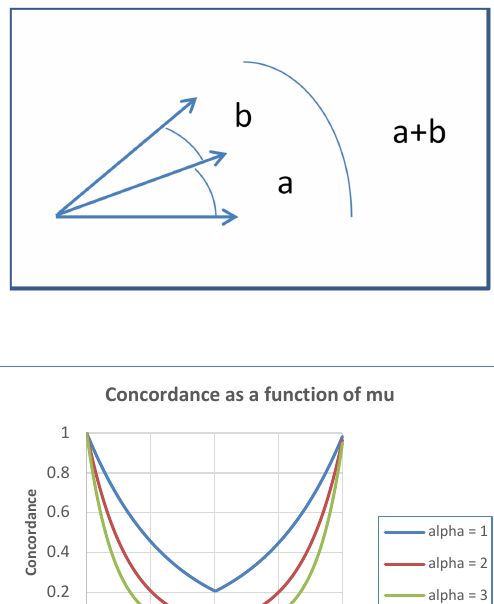
Figure 13. ρ as a function of μ for